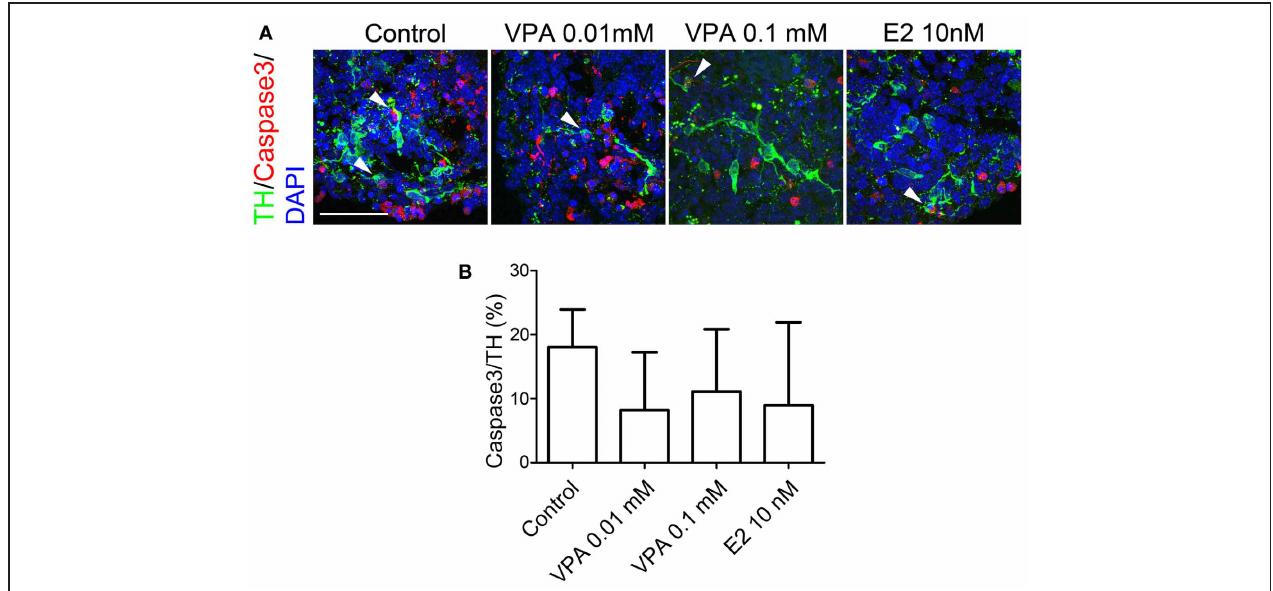
caspase 3 (red) in the control and drug-treated cultures. The arrowheads indicate double-positive cells. The scale bar applies to all pictures and represents 50 μ m. (B) A comparison of the number of TH + cells labeled for caspase 3. The data are presented as the mean ± SD (no significant differences; n =